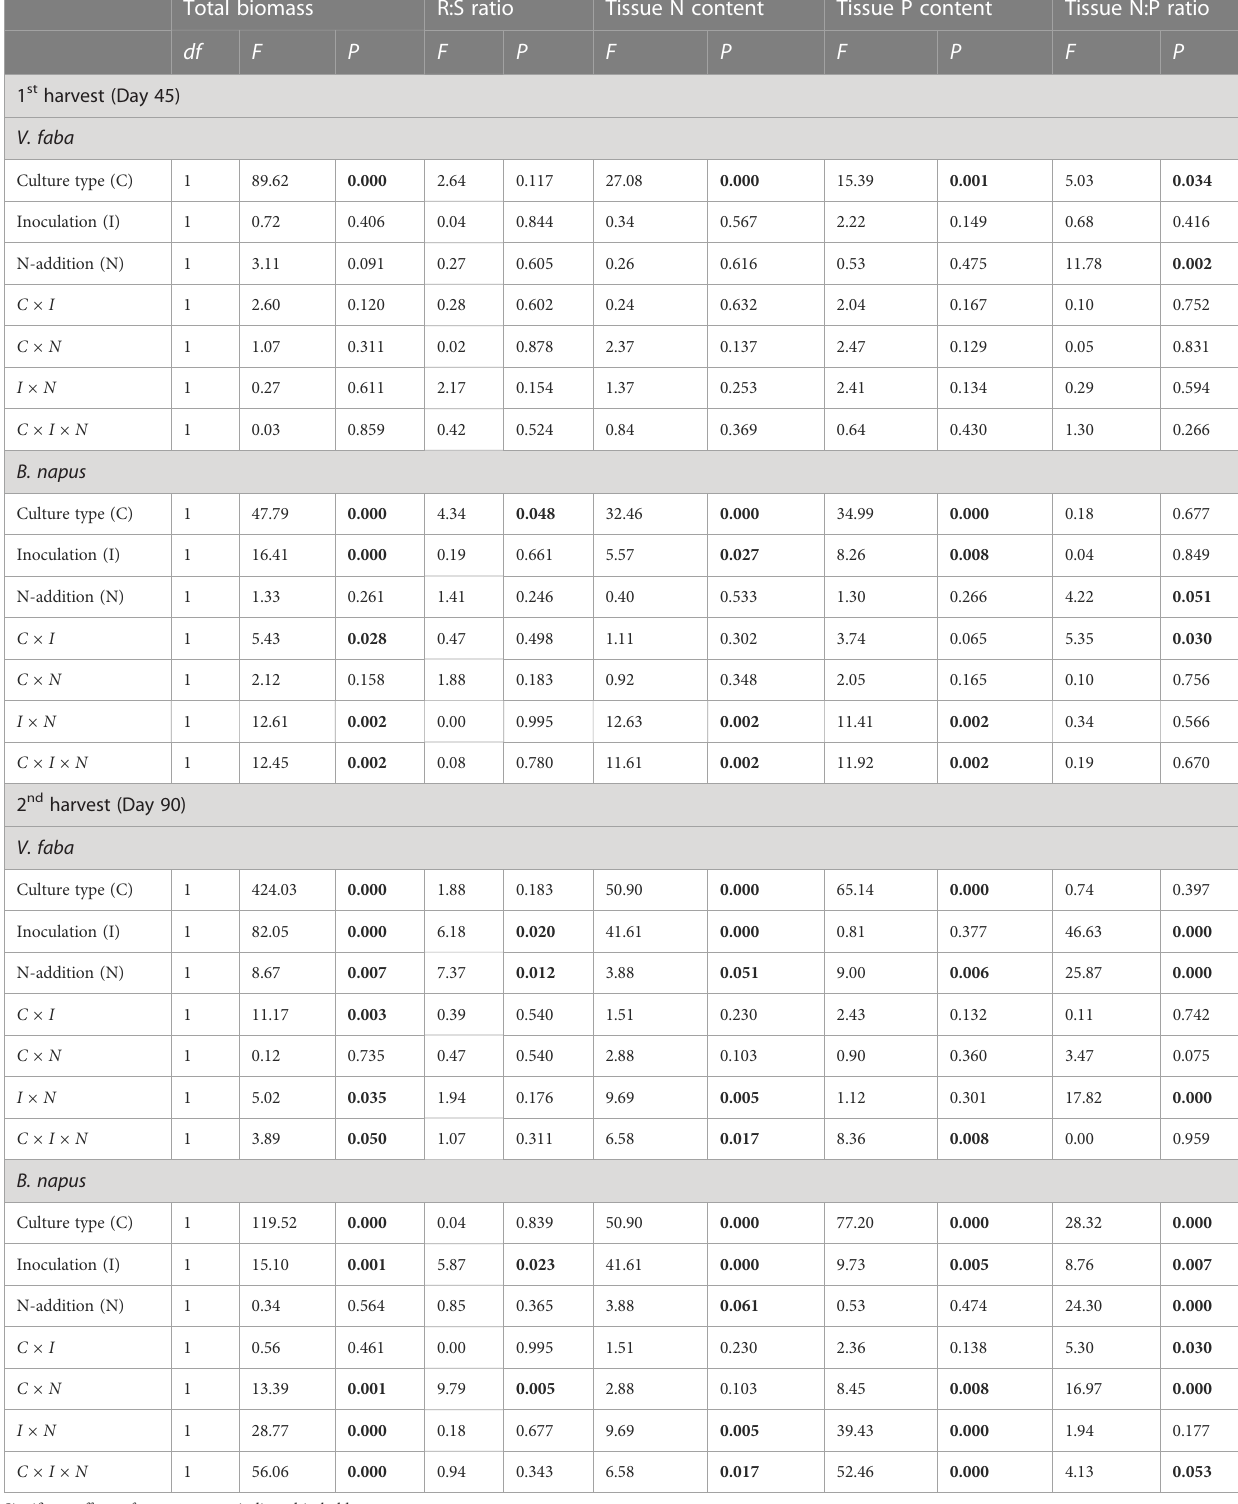
TABLE 2 Analyses of variance (ANOVA) for total biomass, root:shoot ratio, tissue N and P content, and N:P ratio of culture type V. faba and B. napus under AMF inoculation and N-addition conditions of N-0 and